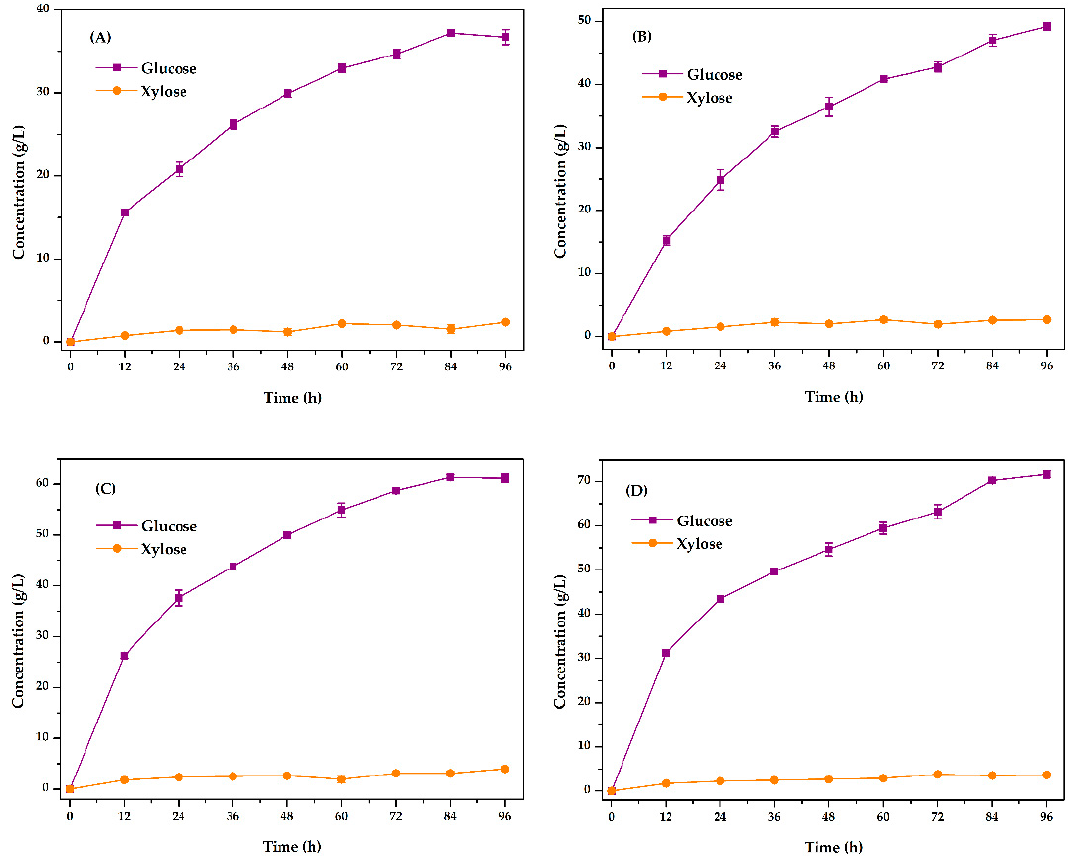
Figure 4. The results of enzymatic saccharification under different fermentation substrate concen- trations. ( A ) Solids content of 8% ( w/v ), ( B ) solids content of 12%, ( C ) solids content of 16%, and ( D ) solids content of 20%.